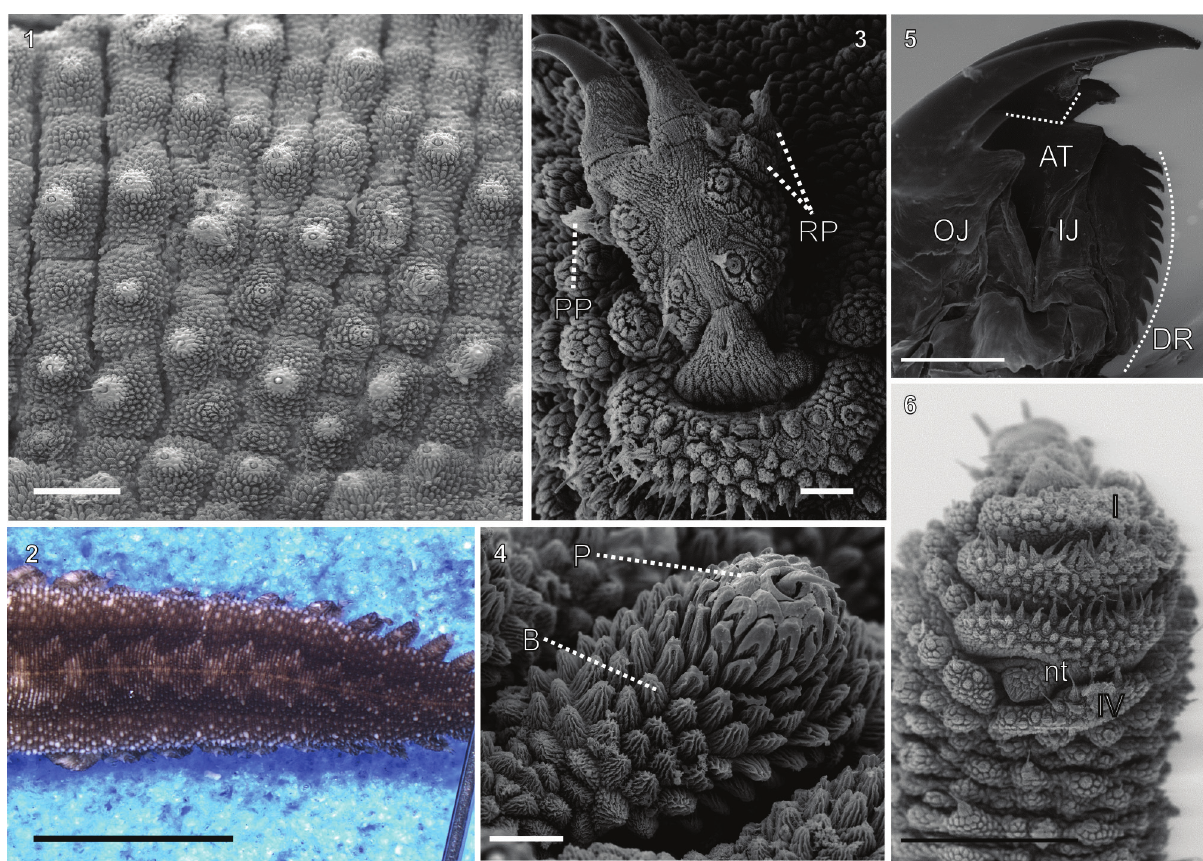
depicting diamond shaped pattern over the dorsomedian furrow; (3) foot in ventral view; (4) primary papillae in posterior view depicting differences in the number and shape of the scales (B and P); (5) outer blade in first plan of right jaw; (6) right fourth leg in ventral view depicting spinous pad undivided (I) and divided (IV) into two unqueal parts. (AT) Accessory tooth, (B) basal piece, (DR) series of denticles, (I) first spinous pads, (IJ) inner blade, (IV) last spinous pads, (nt) nephridial tubercle, (OJ) outer blade, (P) apical piece, (PP) prolateral foot papillae, (RP) retrolateral foot papillae. Scale bars: 1, 5 = 100 µm, 2 = 5 mm, 3 = 30 µm, 4 = 20 µm, 6 = 200 µm.